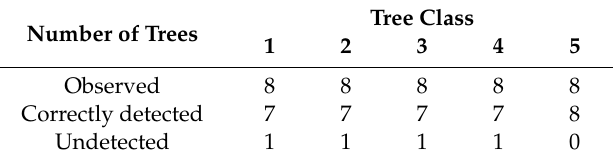
Table 4. Results of tree detection of the 40 observed trees.